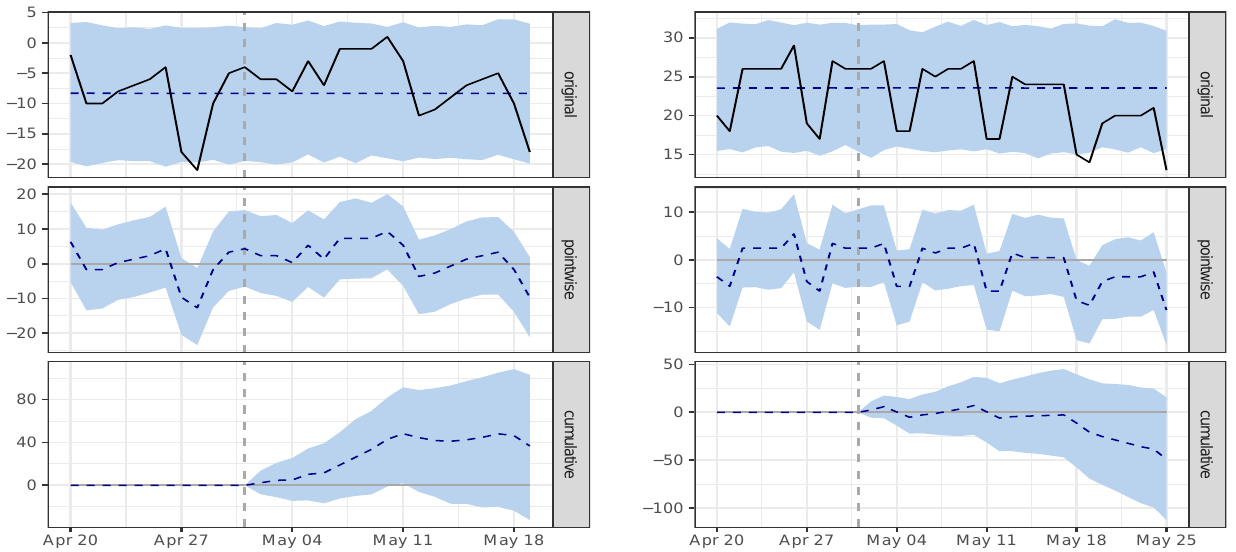
Figure 14. Left : Effect of the national full lockdown Level 5 on parks Right : Effect of the national full lockdown Level 5 on residential places.